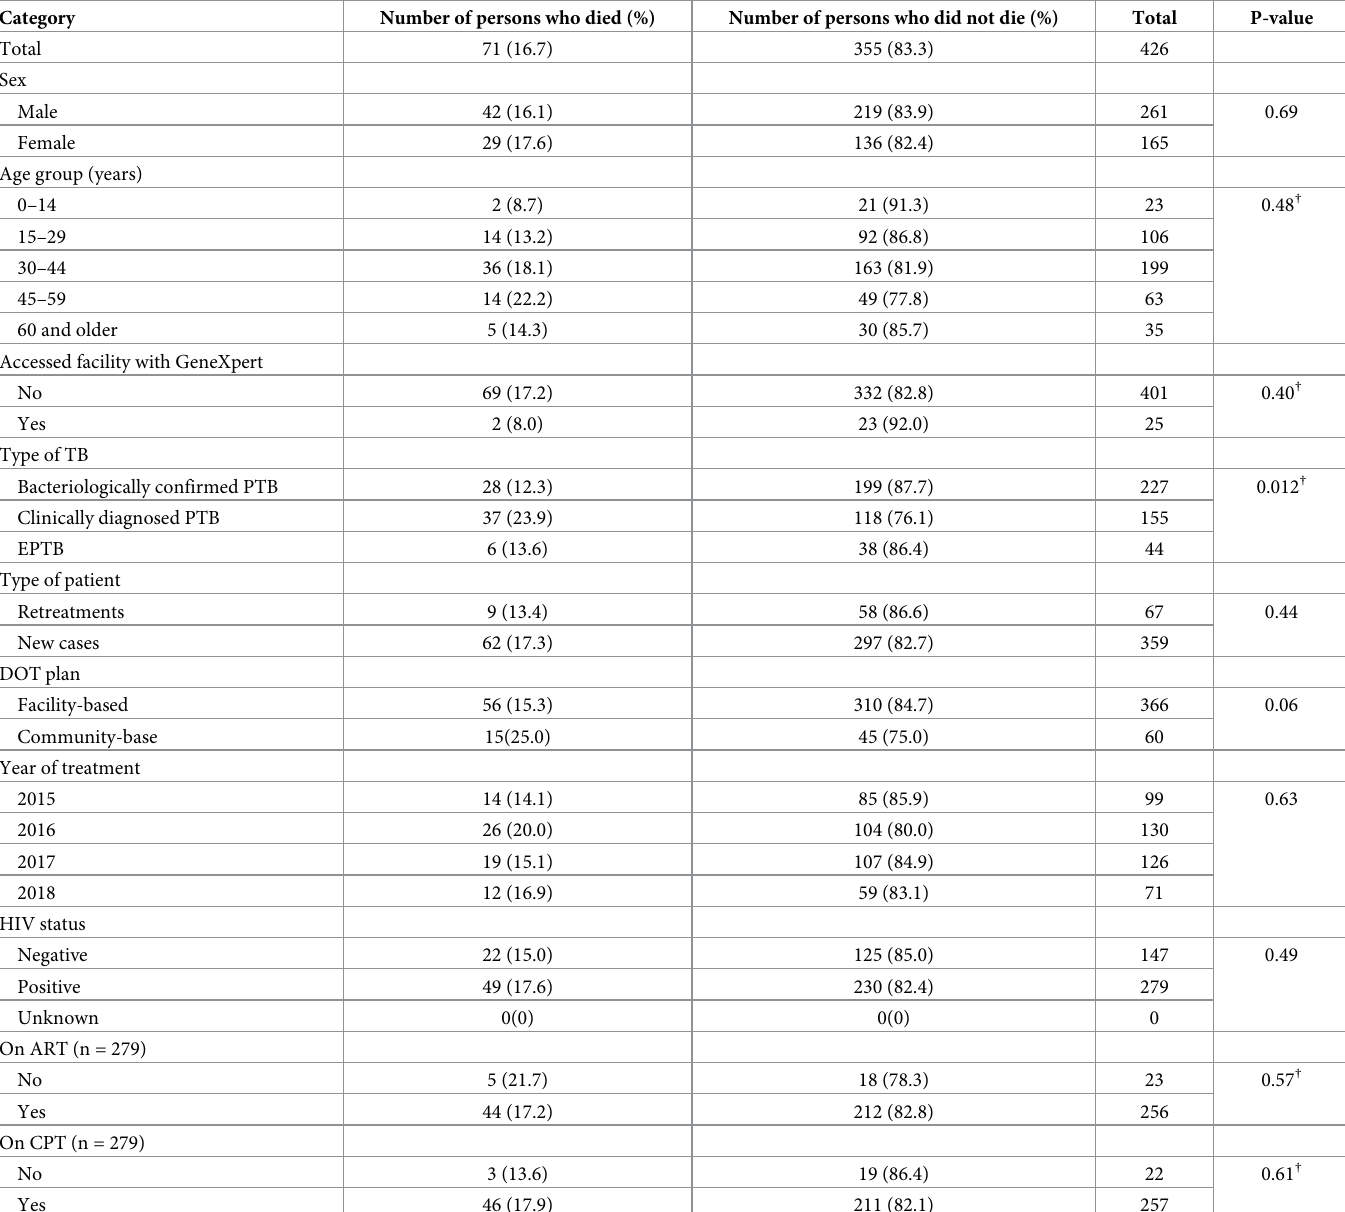
Table 2. Demographic and clinical characteristics of persons with TB in Itezhi-Tezhi District (2015–2018), n =